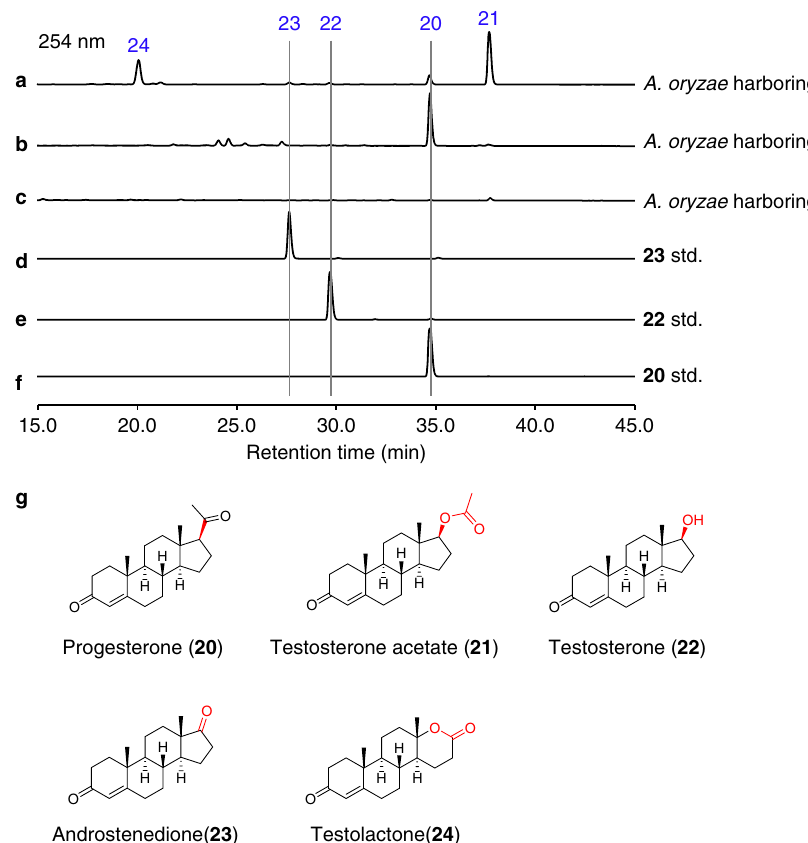
Fig. 7 Progesterone side-chain cleavage by VidF, VidP, and VidH. a A. oryzae harboring vidF + H + P (JA4) with 20 . b A. oryzae harboring empty vectors with 20 . c A. oryzae harboring vidF + H + P . d Standard (std.) of 23 . e Standard (std.) of 22 . f Standard (std.) of 20 . g Structures of compounds 20 − 24 . The enzyme-mediated modi fi cation sites in individual reaction are marked by